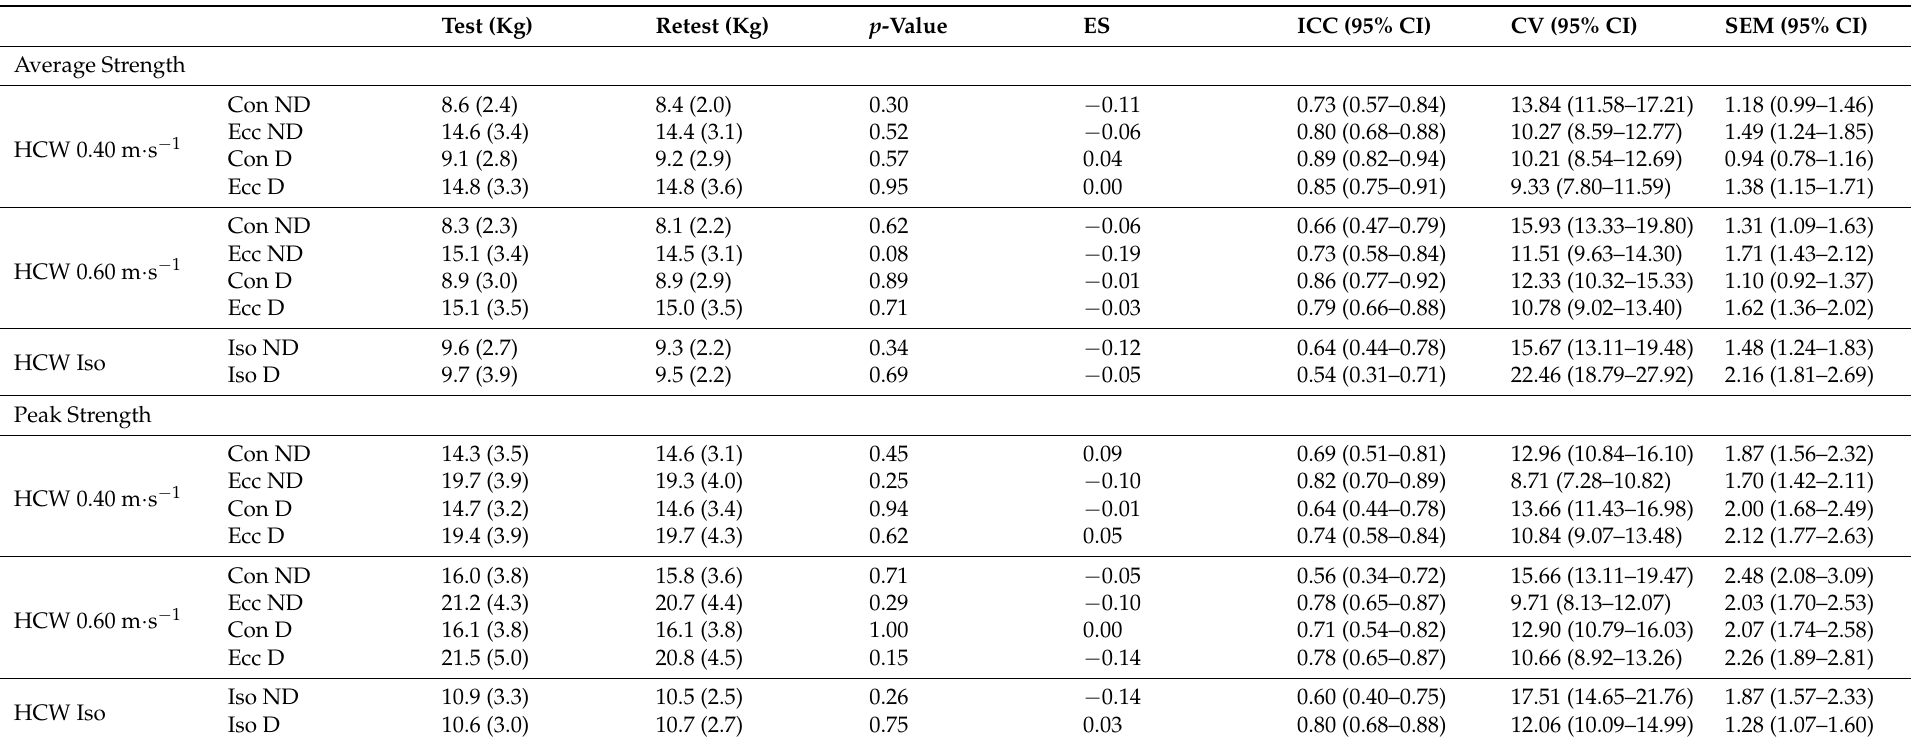
Table 2. Absolute and relative test-retest reliability of the average and peak strength horizontal cable woodchop